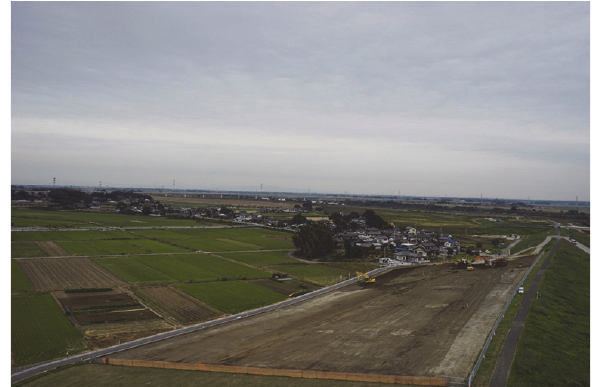
Figure 1. Test field as of October 13, 2016